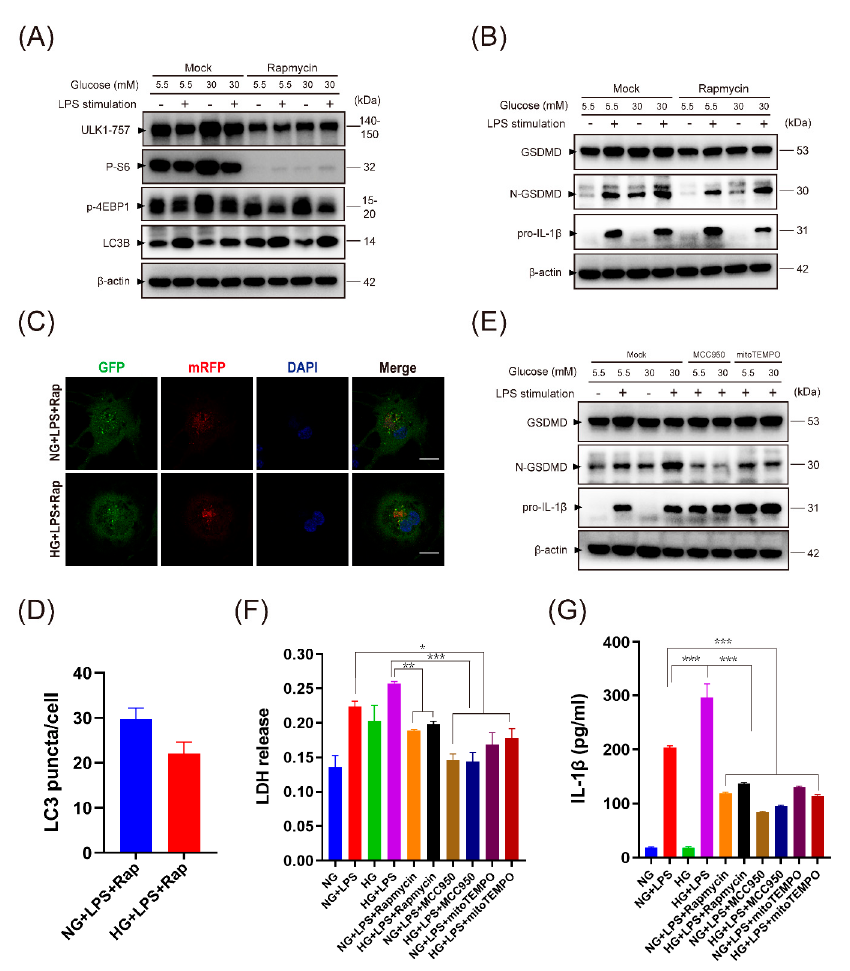
Figure 6. Modulation of autophagy and ROS-inflammasome pathway reduced IL-1 β secretion and pyroptosis. ( A – D ) Macrophages were pretreated with rapamycin (200 nM) 2 h before LPS stimulation. Proteins related to mTOR pathway, autophagy ( A ), and pyroptosis ( B ) were assessed by Western blot. ( C , D ) Representative microscopic images and quantification of LC3 puncta (scale bar: 10 µ m). ( E ) MCC950 (5 µ M) and mitoTEMPO (10 µ M) were added to the media 2 h before LPS stimulation and were maintained until assays were performed. GSDMD, N-GSDMD, and pro-IL-1 β were measured. ( F ) LDH in the supernatant to measure cell lysis. ( G ) Measurement of IL-1 β by ELISA. Data in ( D , F , G ) are shown as mean ± SD. * p < 0.05. ** p < 0.01. *** p < 0.001. LDH, lactate